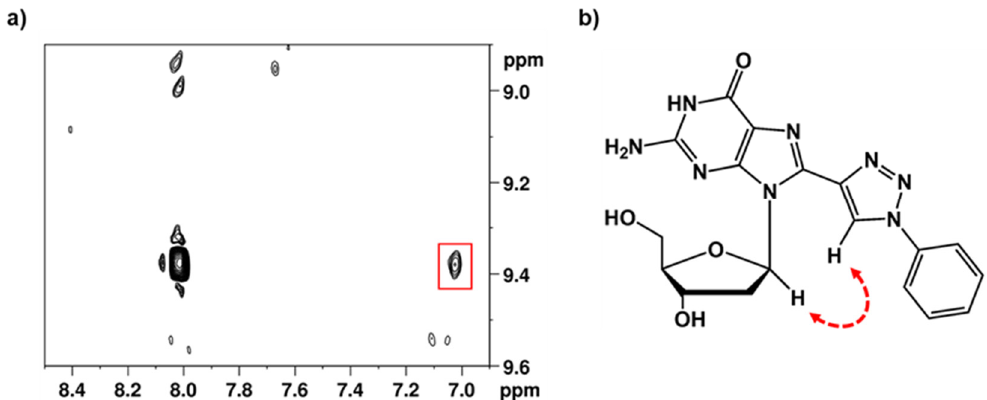
Figure 2. ( a ) NOESY spectrum of 8 et dG click reaction product. Cross peak between H in the triazole ring and H1 ′ is in the red box. ( b ) Schematic representation of syn glycosidic conformation of 8 et dG click reaction product with arrows indicating the NOEs.